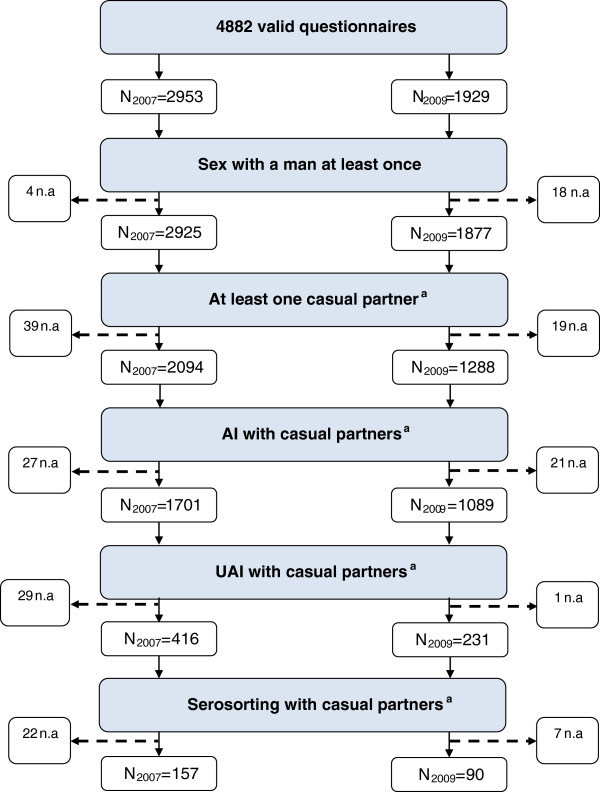
Filters applied for analyses: population under study.